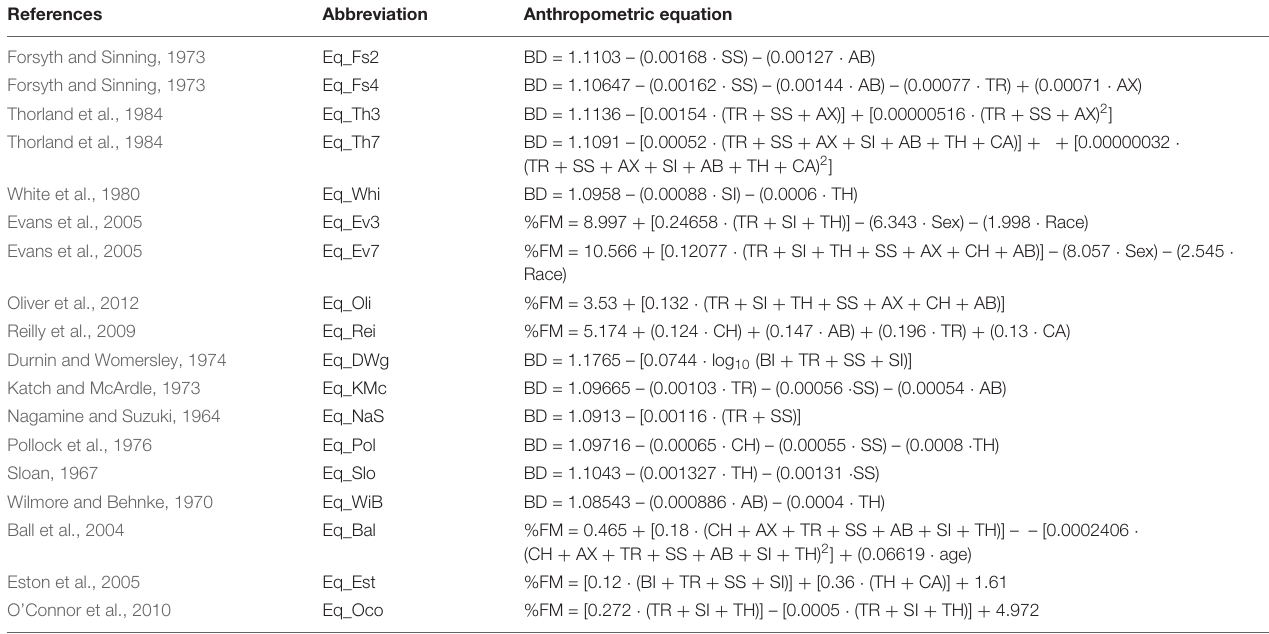
TABLE 1 | Anthropometric equations used to predict the body density or the percentage of body fat in athletes with unilateral lower limb